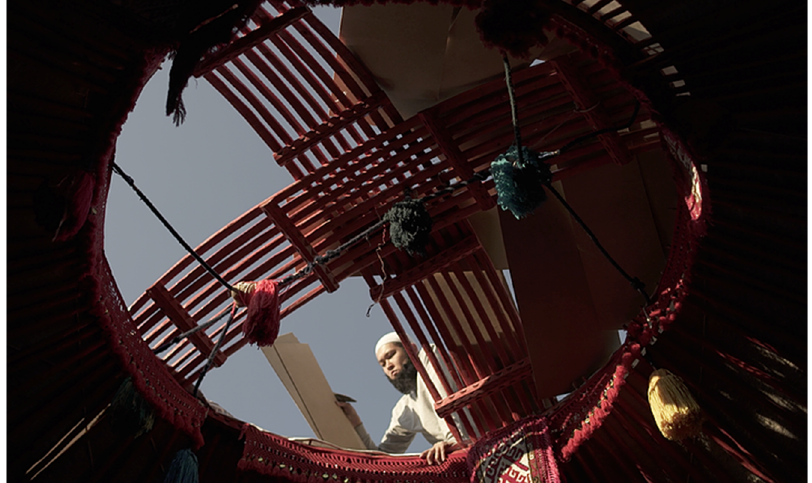
Figure 3. Anvar Musrepov, still from the video Haram (Sin) (2016). Image courtesy of the artist.